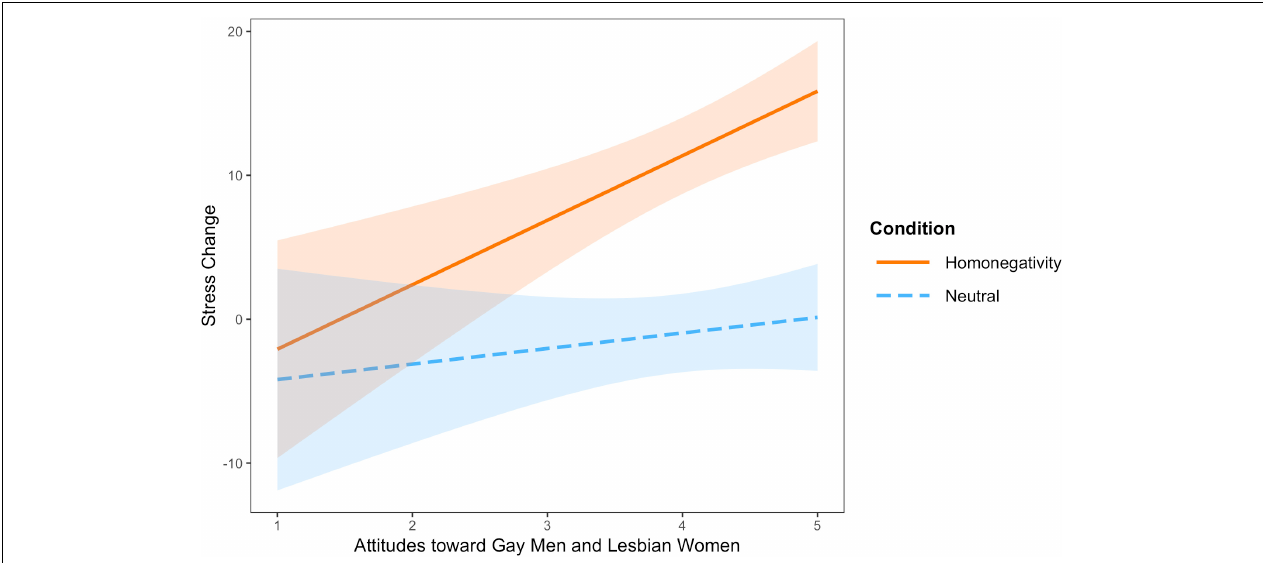
FIGURE 1 | Interaction between stress condition and attitudes toward sexual minorities in predicting stress change. Stress was measured on a visual analogue scale from 0 to 100 (see text). Attitudes toward sexual minorities range from 1 to 5, with higher scores indicating more accepting attitudes. Shading represents 95% confidence